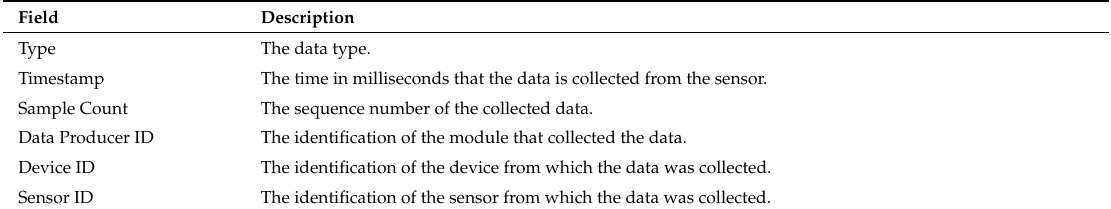
Table 3. Description of the data attributes from sensor data